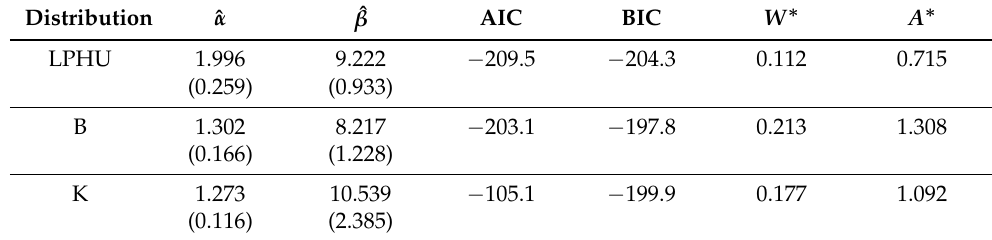
Table 3. ML estimates (with SE in parentheses), AIC and BIC values, and modified AD ( W ∗ ) and CvM ( A ∗ ) statistics for the LPHU, B, and K distributions fitted to a single sample obtained from the household shared budget proportion